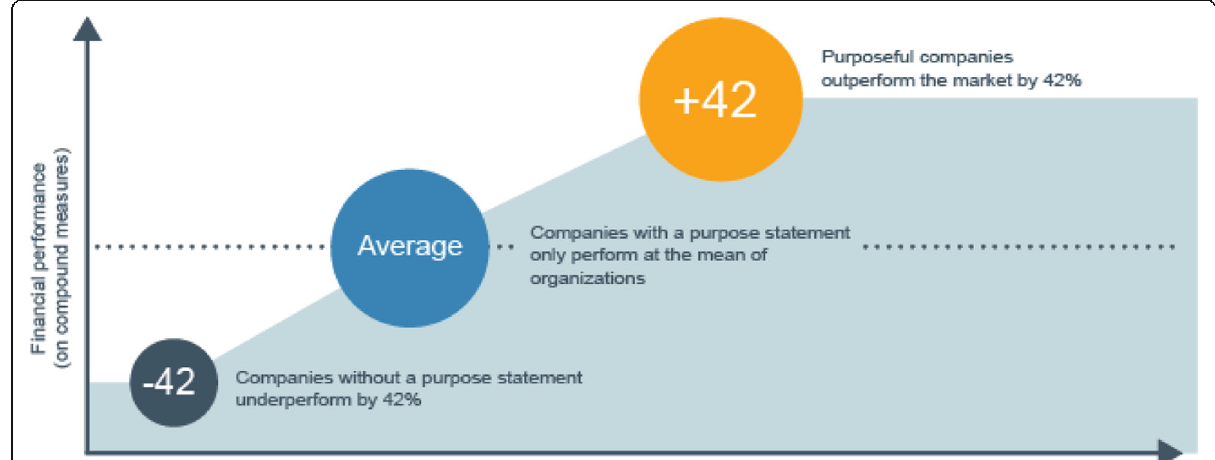
Fig. 2 Impact of Purpose on Financial Performance. Source: DDI (2018), Global Leadership Forecast 2018: 25 Research Insights to Fuel Your People